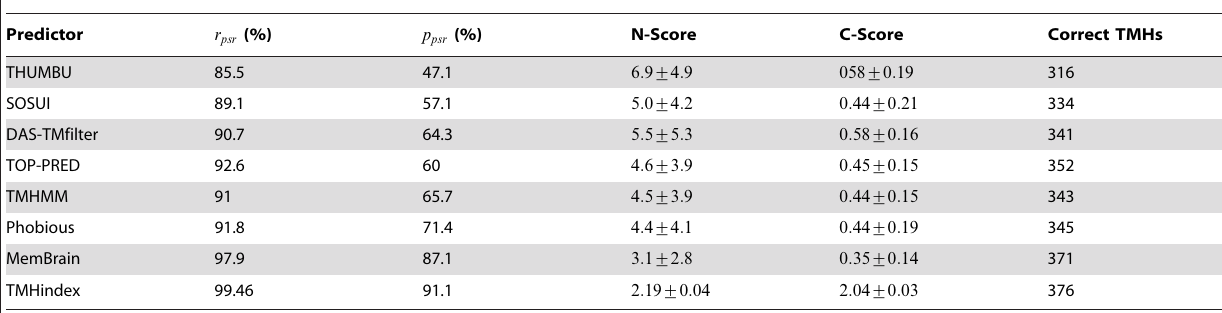
Table 2. Performance comparison of various TMH